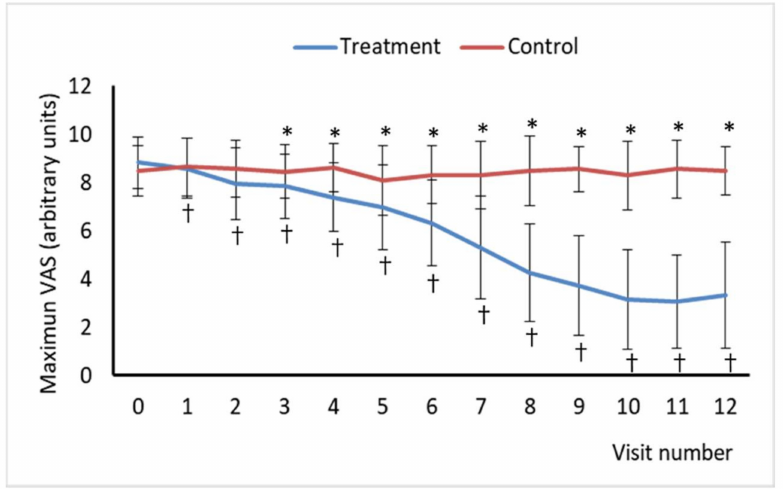
Figure 3. Maximum Visual Analogue Scale (VAS) of Pain scores for visits 0 to12. Maximum VAS represents the highest daily pain intensity measure collected during the last 5 days prior to the visit. Asterisk (*) indicates a statistically significant difference between the treatment and control groups at the same visit. Cross (†) indicates a statistically significant difference compared to the baseline (visit 0) for an experimental